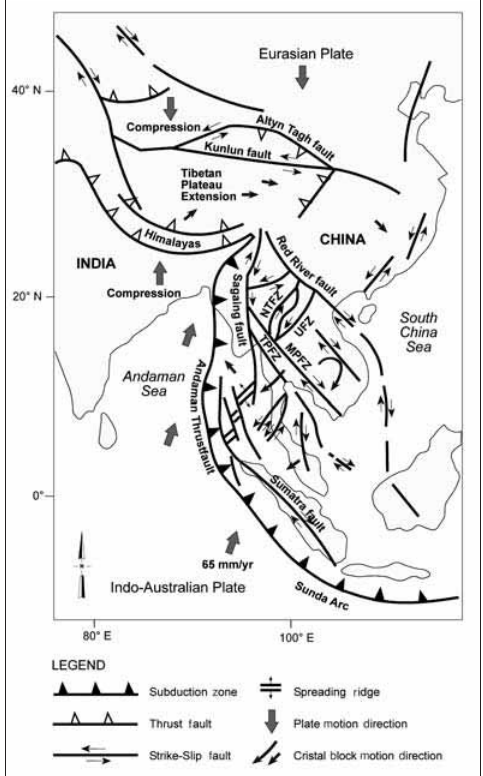
Fig. 1. Major tectonic elements in Southeast Asia and Southern China. Arrows show relative directions of motion of crustal blocks during the Late Cenozoic. MPFZ - Mae Ping Fault Zone; NTFZ - Northern Thailand Fault Zone; TPFZ - Three Pagodas Fault Zone; UFZ - Uttaradit Fault Zone. Modified from Polachan et al .